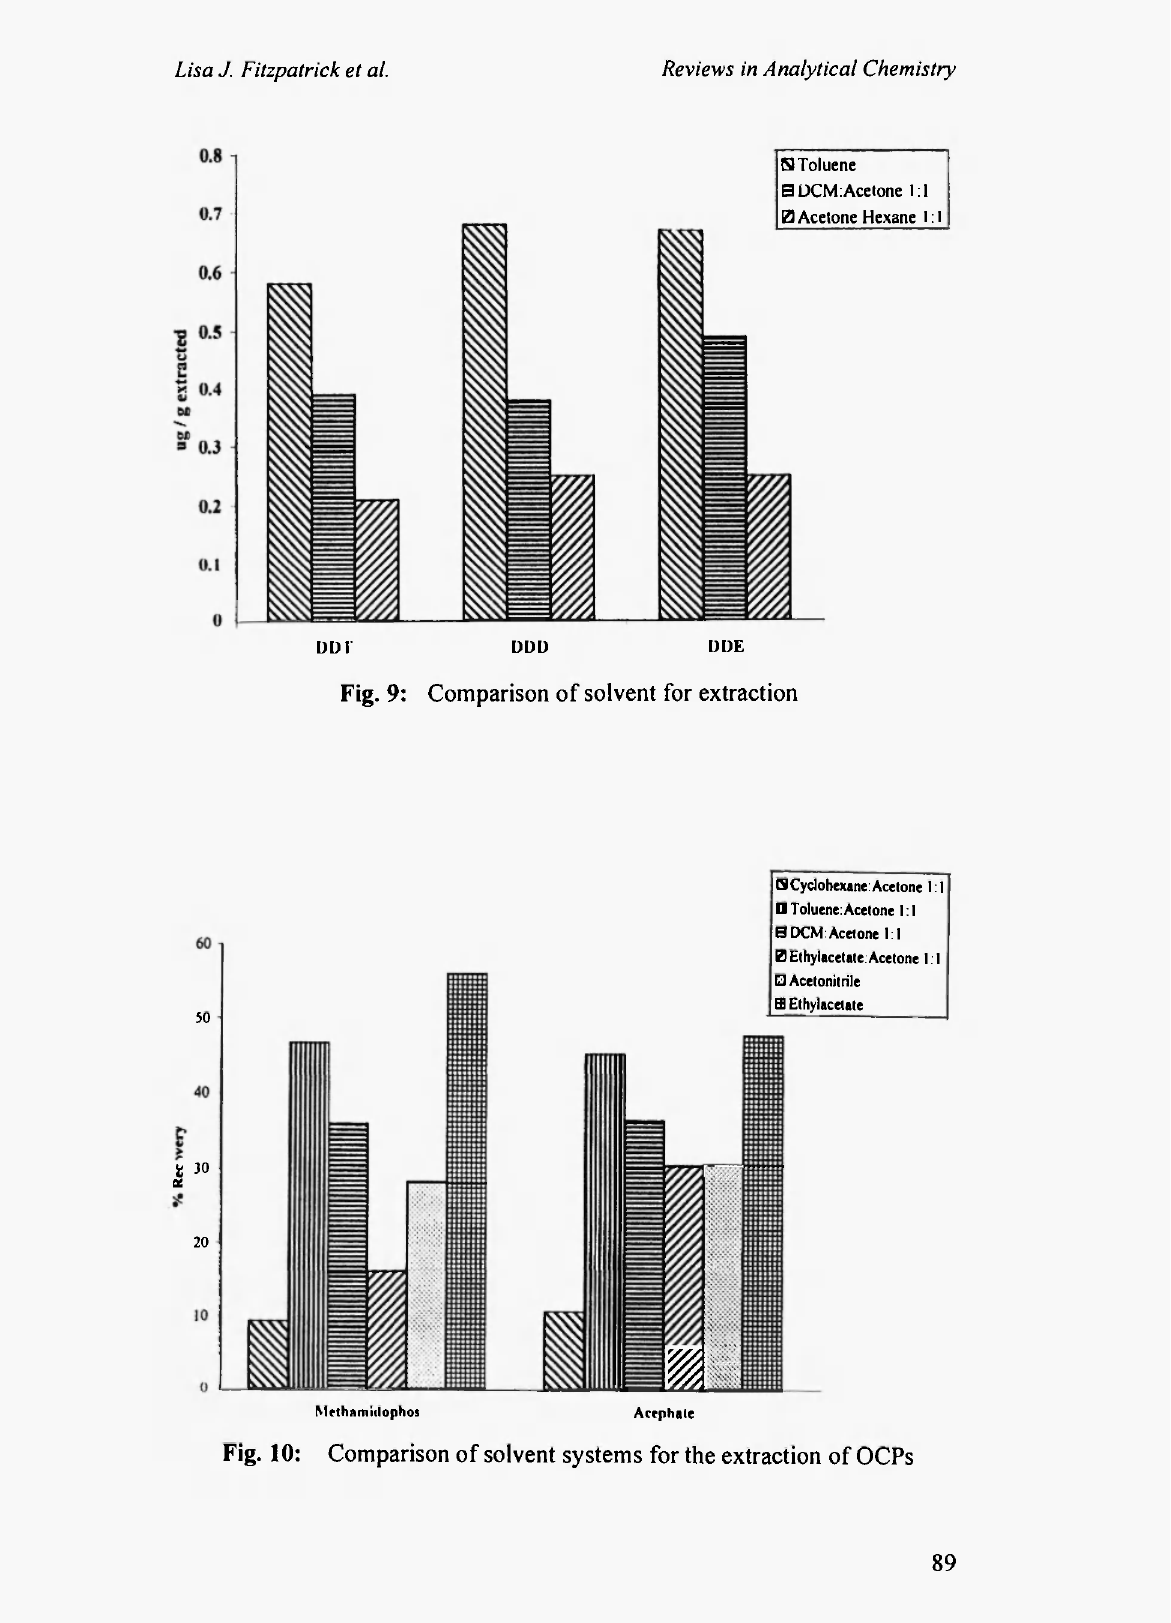
Fig. 10: Comparison of solvent systems for the extraction of